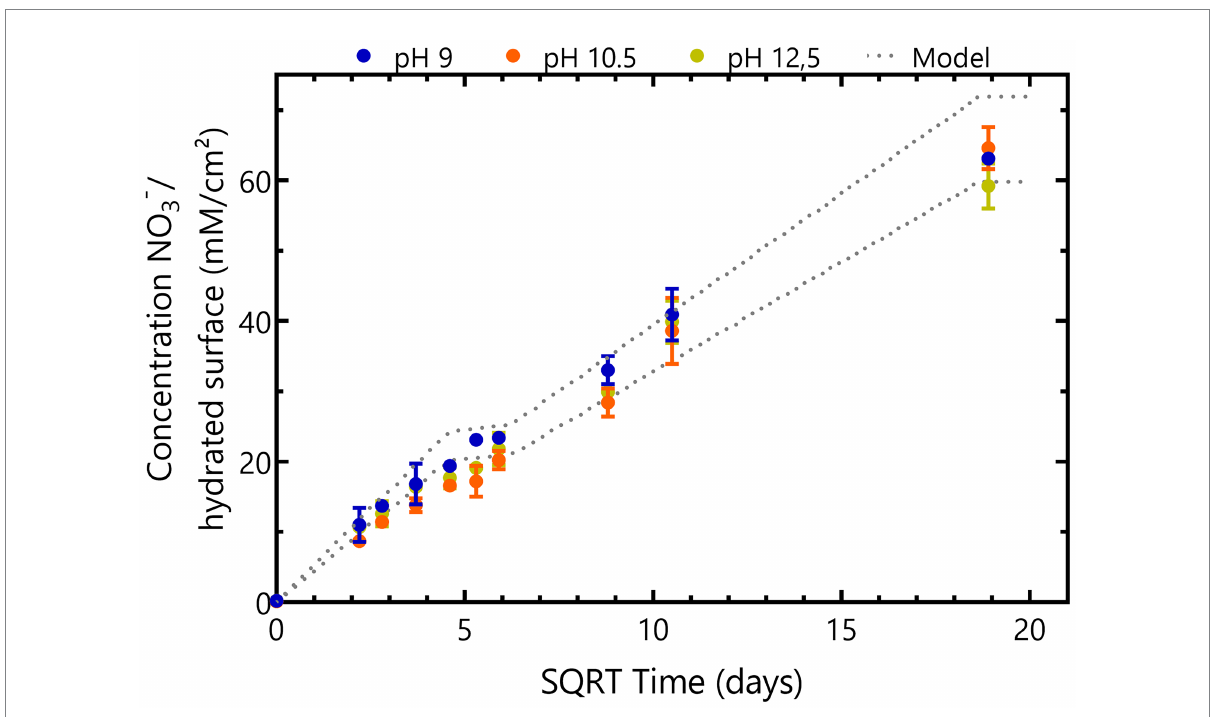
FIGURE 2 Time evolution of NaNO 3 concentrations in abiotic samples leached from thermally aged non-radioactive bituminized waste under free swelling conditions. Concentrations of conditions with initial pH 9 are presented in blue, conditions with initial pH 10.5 are shown in yellow and orange represents conditions with initial pH 12.5. Values represent the average and standard deviation of two replicates for pH 9 and pH 10.5 and three replicates for pH 12.5. The dotted line represents the maximum expected leaching rates where the lowest line shows the calculated leaching rates for the Eurobitum cube containing the least amount of nitrate and the highest line represents the Eurobitum cube containing the most NaNO 3 . After 348 days (the start of the second plateau), all nitrate is expected to be leached from the Eurobitum